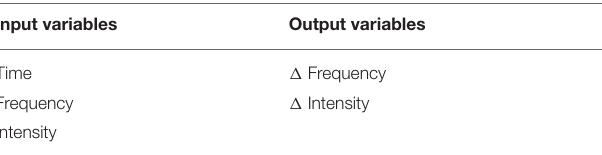
TABLE 3 | Input and output variables for the single particle sound synthesis